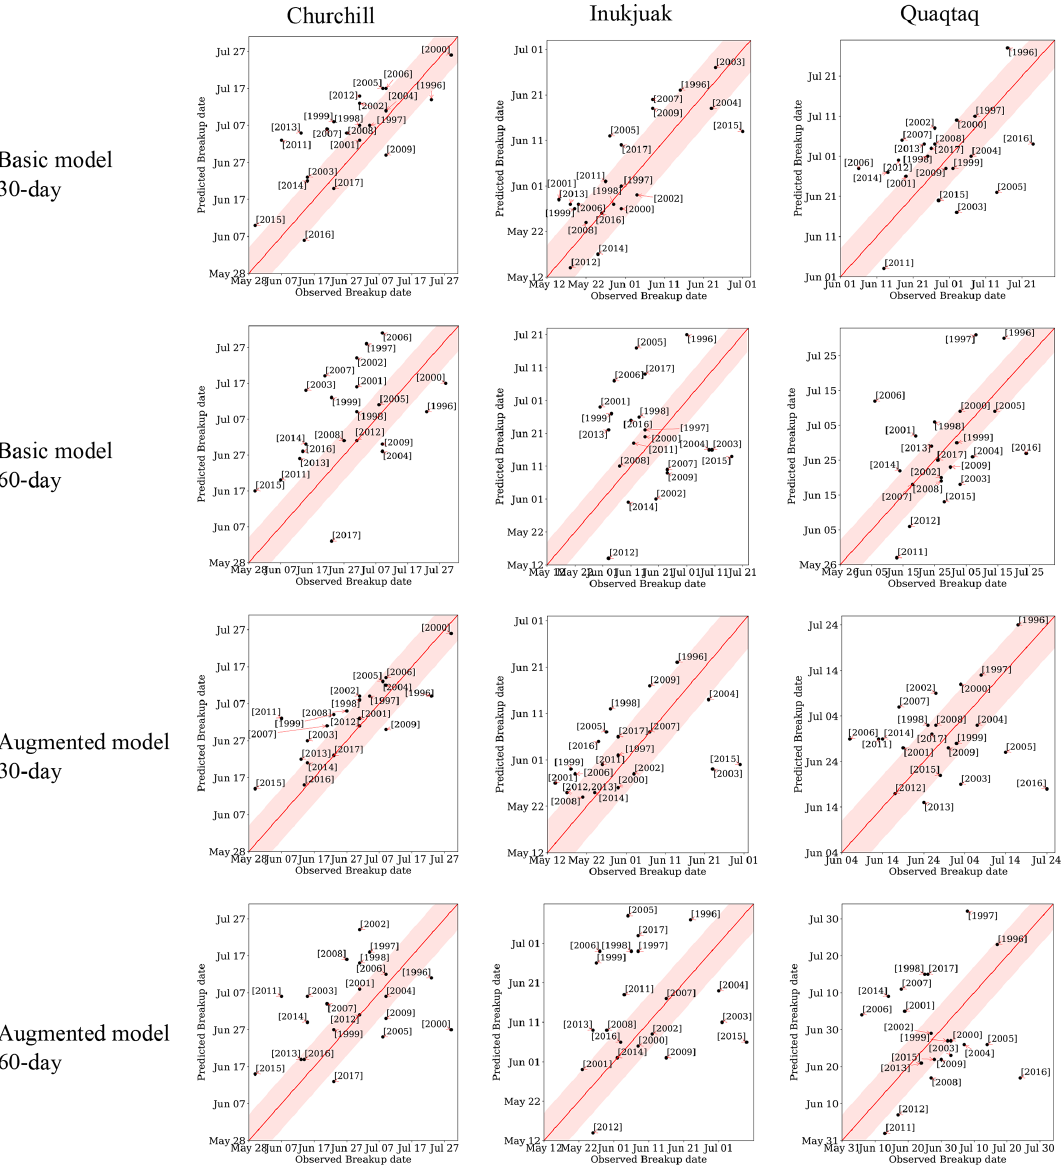
Figure 12. Comparison between forecast and observed breakup dates at pixels located in the vicinity of ports in the study region for 30 and 60 lead days. Each dot represents 1 year. The red line represents perfect predictions, and the pink area represents ± 7d of the red line, which is commonly assumed to be an acceptable error